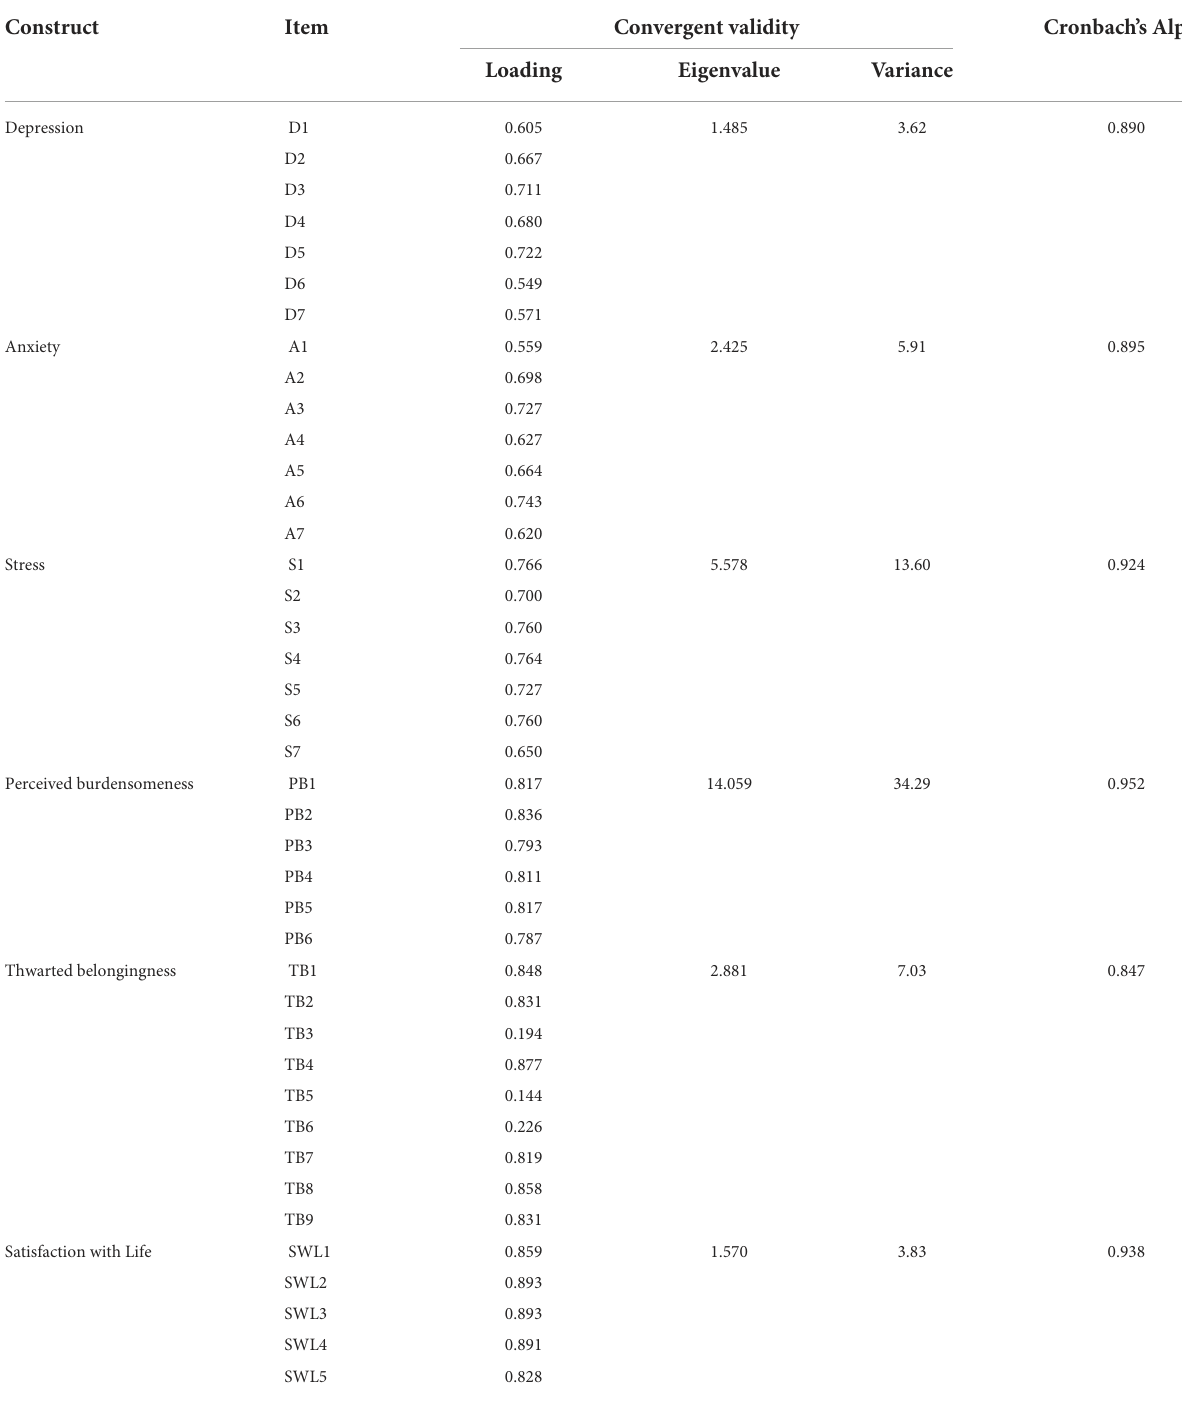
TABLE 3 Results of factor